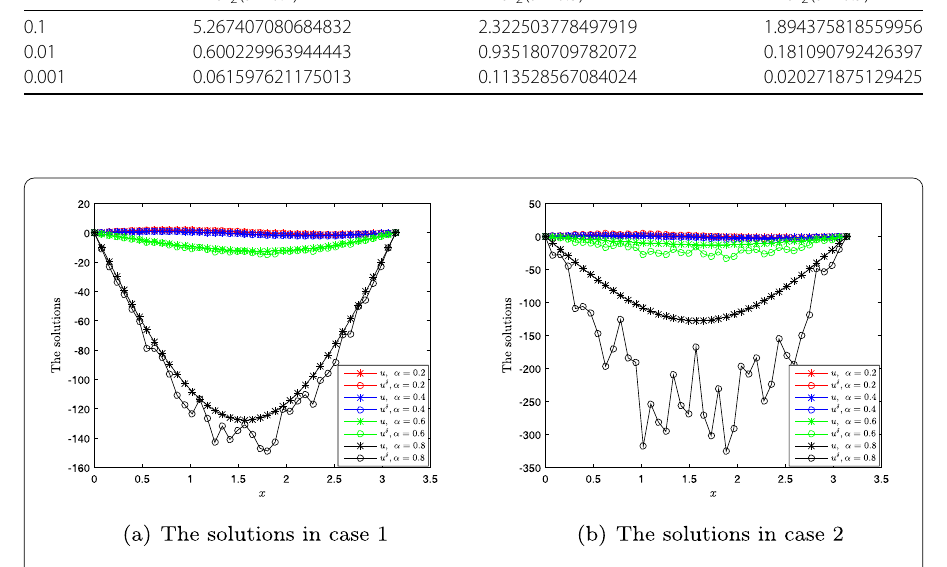
Figure 2 A comparison between the exact and regularized solutions of the proposed method (case 1) and according to [19] (case 2) at t = 0.1 for α ∈ { 0.2;0.4;0.6;0.8 } , δ = 0.1, and N x = N t = 40